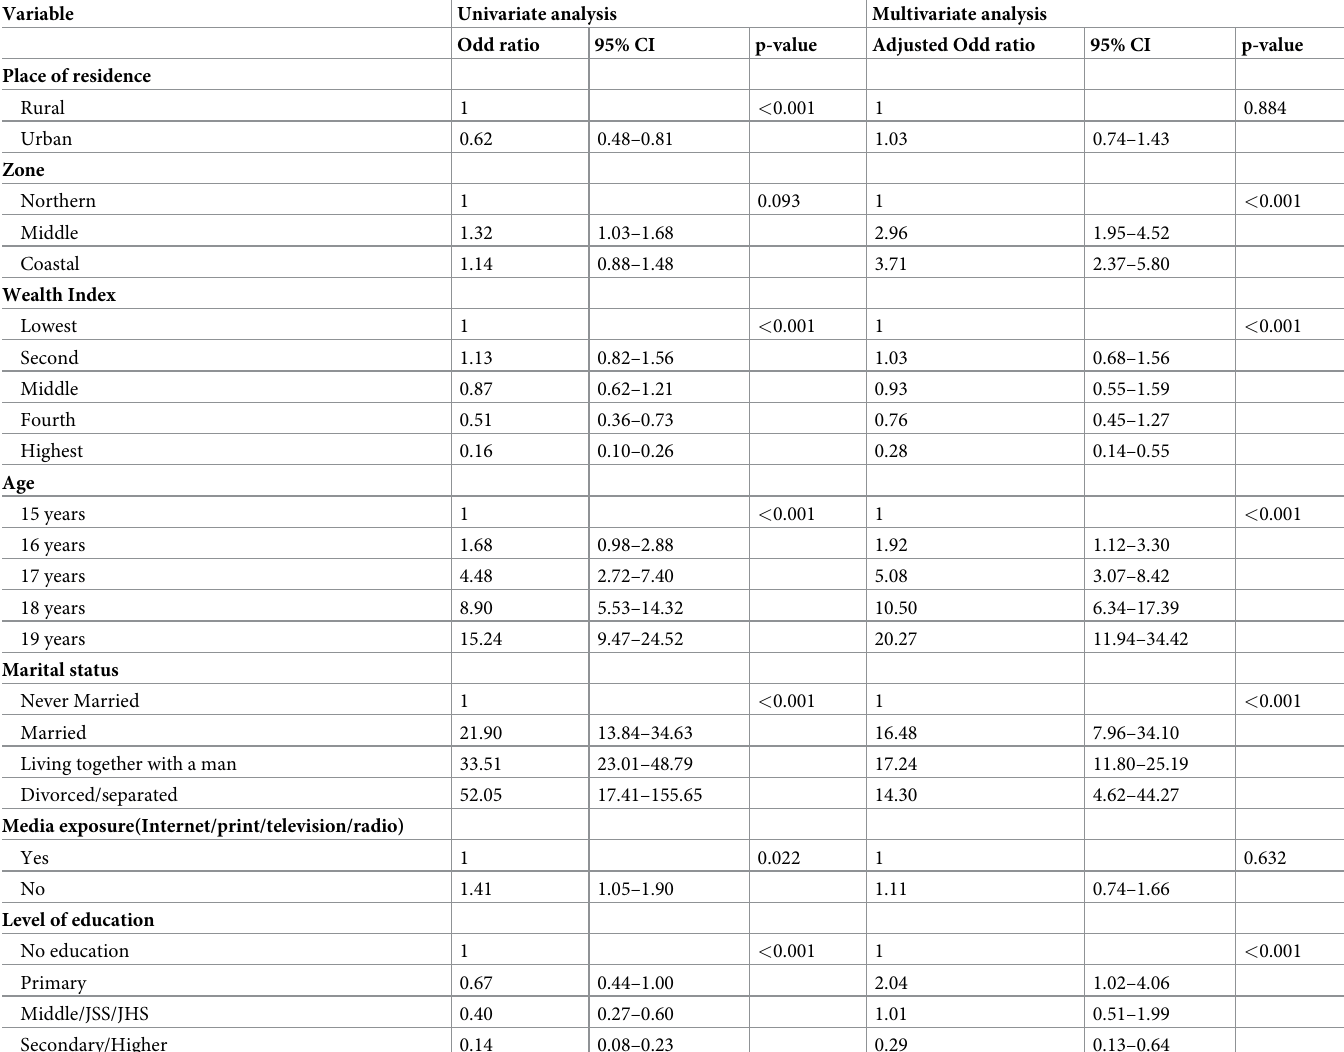
Table 4. Association of demographic factors with adolescents (aged 15–19 years) adolescent